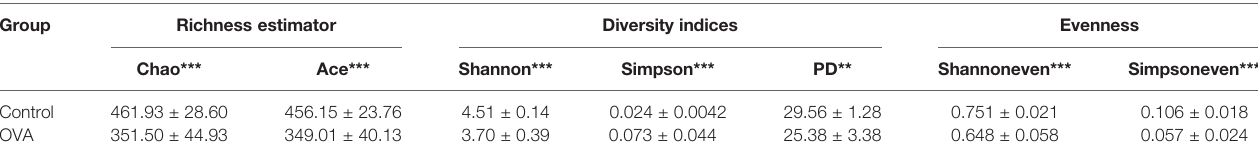
TABLE 1 | Comparison of a -indices of gut microbiota species in two groups. Group